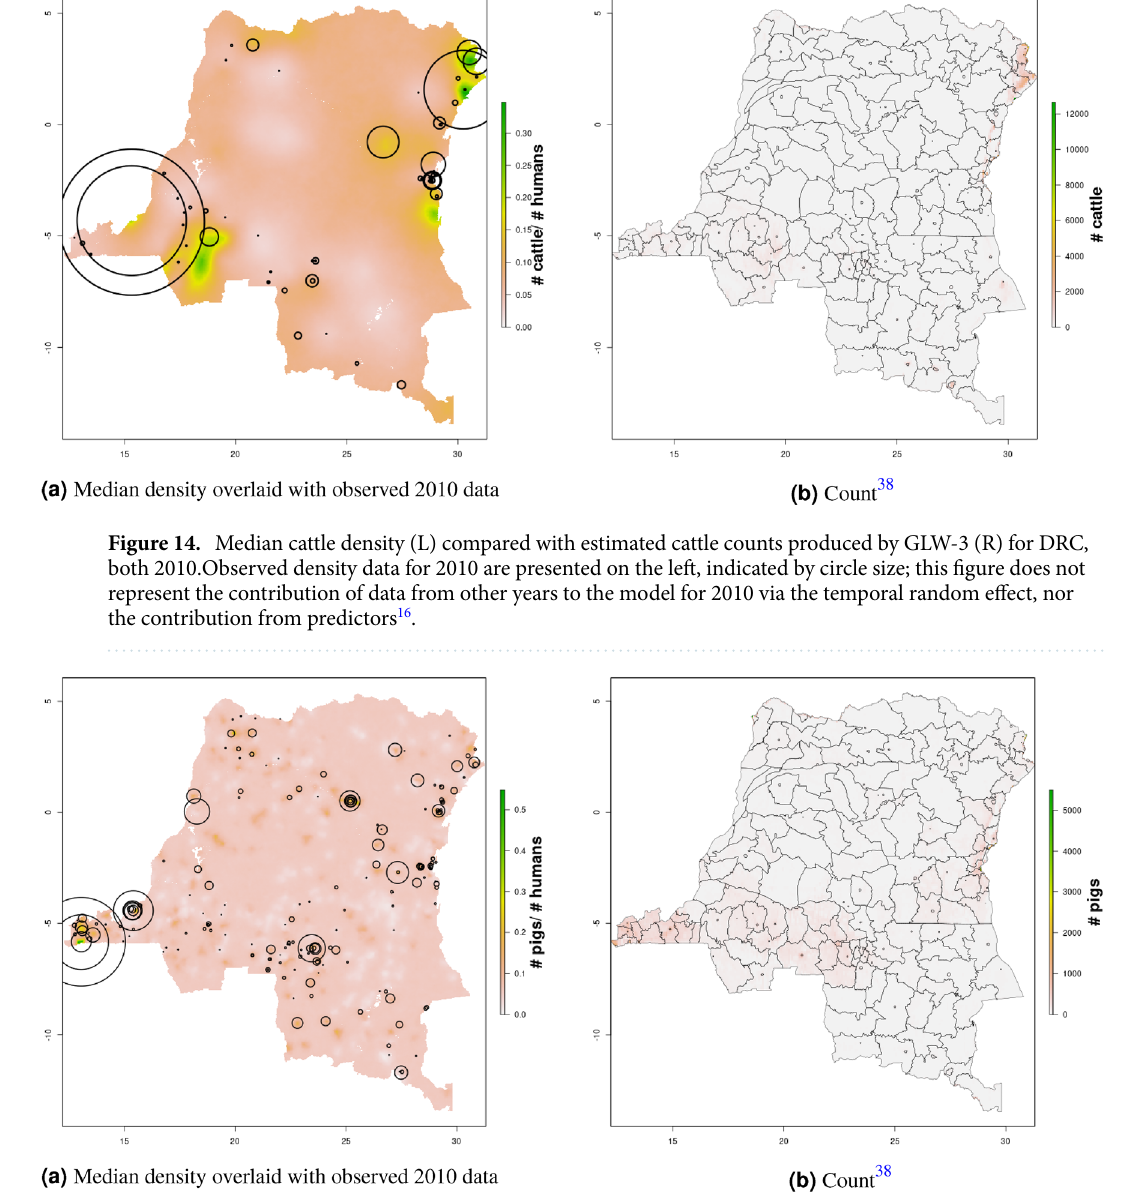
Figure 15. Median pig density (L) compared with estimated pig counts produced by GLW-3 (R) for DRC, both 2010.Observed density data for 2010 are presented on the left, indicated by circle size; this figure does not represent the contribution of data from other years to the model for 2010 via the temporal random effect, nor the contribution from predictors 16